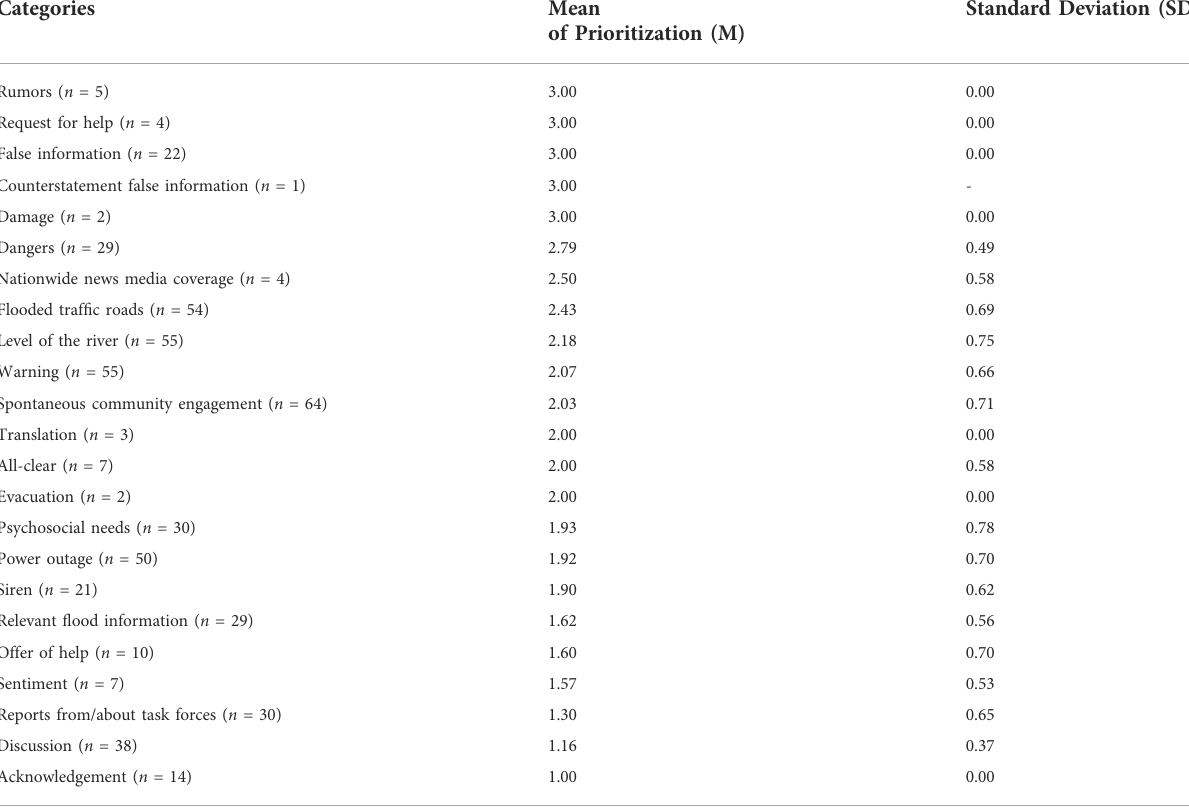
TABLE 1 Categories and prioritization.